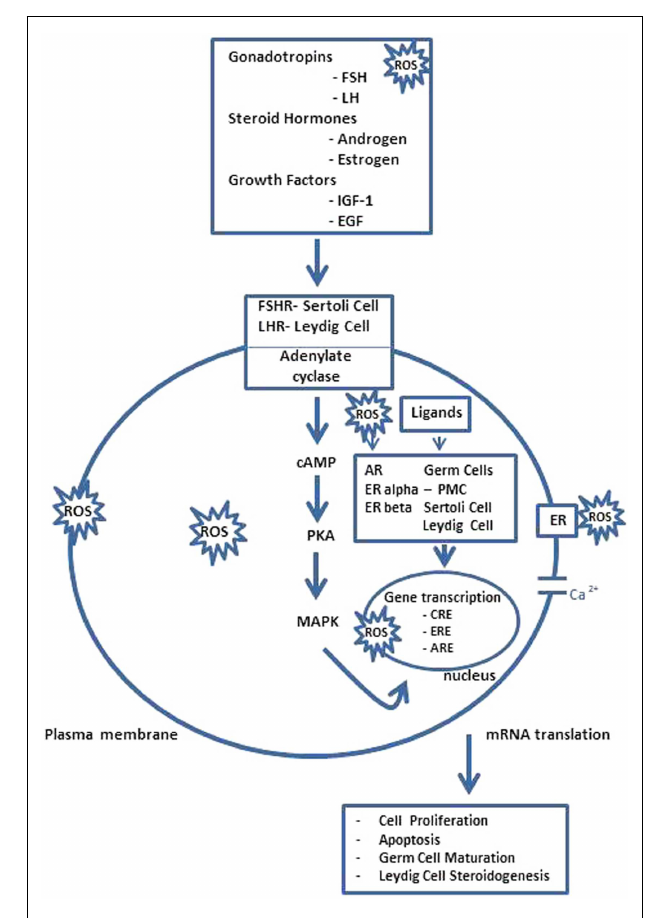
FIGURE 2 | Spermatogenesis ROS endocrine gene transcriptional regulation . FSH acts through its receptors in Sertoli cells (FSHR) to regulate the spermatogenesis and LH stimulates androgen production by Leydig cells after binding to LHR. However, steroid hormones, i.e., androgen and estrogen, and other agents that bind or prevent binding to steroid hormone receptors, which are present in Sertoli cells, germ cells, and Leydig cells also regulate testicular function as several growth factors, e.g., insulin like growth factor-1 (IGF-1) and epidermal growth factor (EGF), acting via their receptors possibly modulate AR and ERalpha and beta-mediated pathways.The pathway, mediated by adenosine monophosphate (cAMP), appears to be the primary intracellular signaling pathway in all testicular cells and stimulates the cAMP-dependent protein kinase (PKA).Thus, testicular function is disrupted by interactions between ROS and lipids, proteins, DNA, and several signaling pathways, some acting locally, e.g., AR and ER-mediated pathways, and others indirectly by modulating hypothalamus–pituitary function. Hormonal activation of transcriptional gene activity results in changes in cell differentiation and function. PMC, peritubular myoid cell; CRE, cAMP responsive elements; ARE, androgen-responsive elements; ERE, estrogen-responsive elements [modified from Ref.